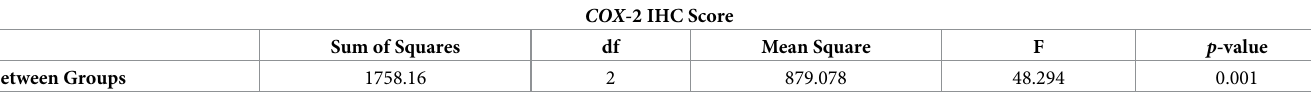
Table 2. COX -2 IHC Score using ANOVA between groups.